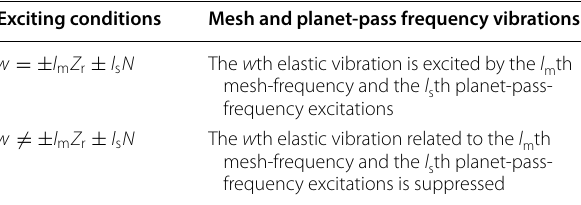
Table 3 Exciting conditions for mesh and planet-pass